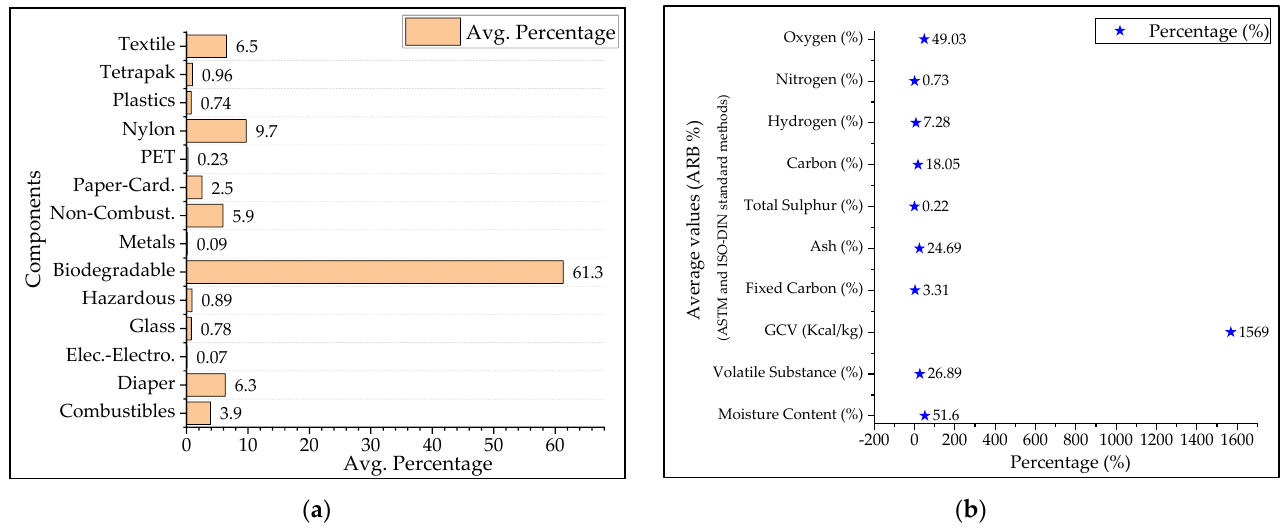
Figure 9. Average percentage of physical & chemical waste components [98]: ( a ) Physical composition of waste (avg.); ( b ) Chemical composition of waste (avg).